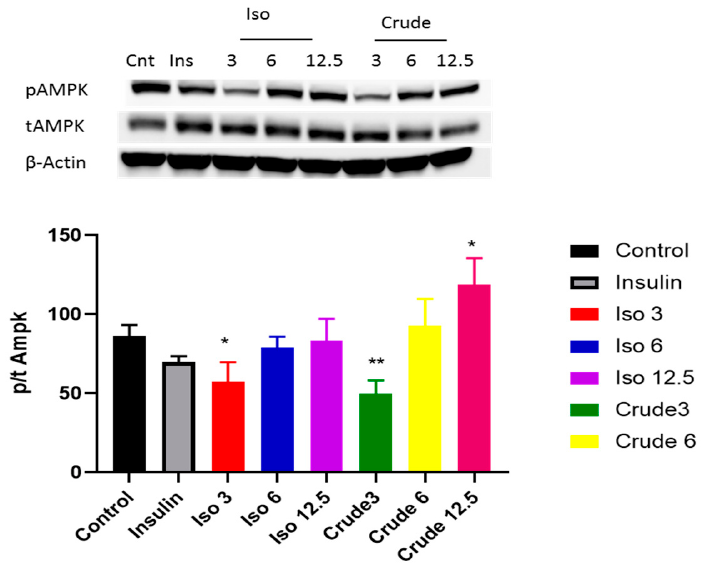
Figure 5. The e ff ect of iso-mukaadial acetate and crude extract on AMP-activated protein kinase (AMPK) protein expression in L6 skeletal muscle cells. Results are expressed as mean ± SEM of three independent experiments. Levels of significance * p < 0.05, ** p < 0.01 versus, Iso 3: iso-mukaadial acetate 3 µ g / mL, Iso 6: iso-mukaadial acetate 6 µ g / mL, Iso 12: iso-mukaadial acetate 12.5 µ g / mL, Crude 3: crude extract 3 µ g / mL and Crude 6: crude extract 6 µ g /